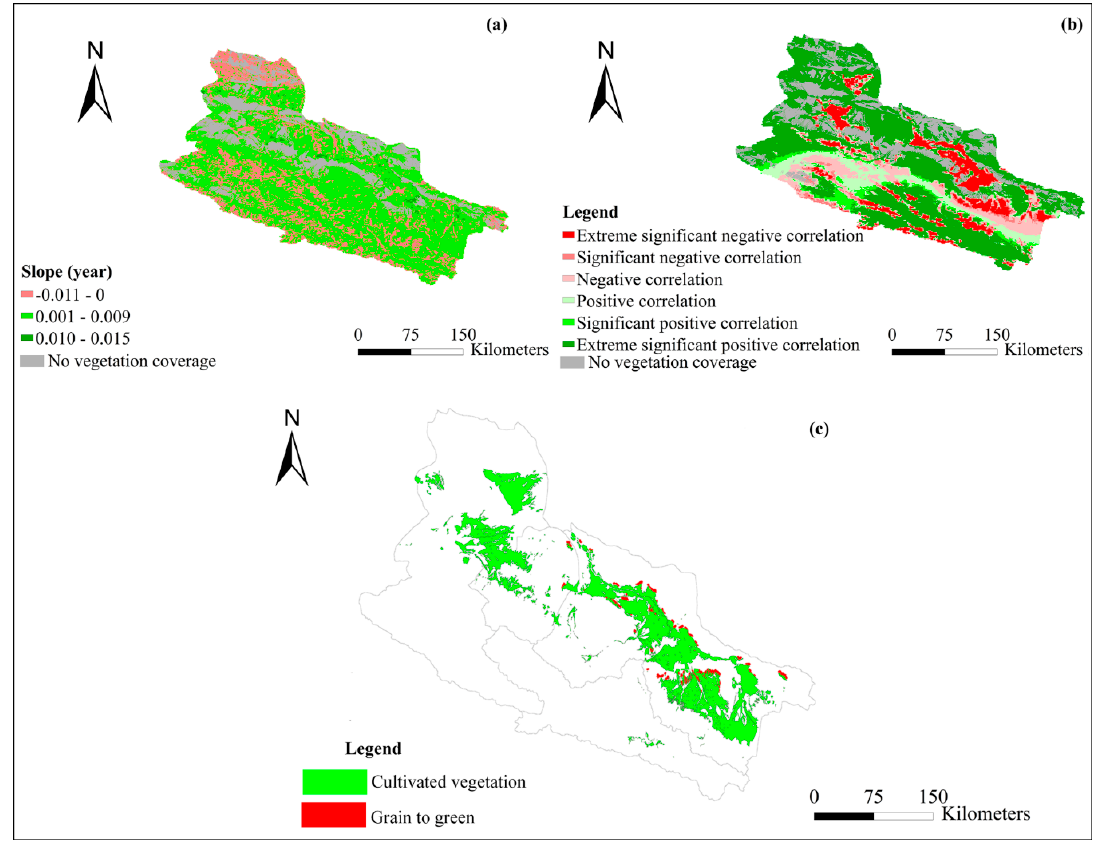
Figure 10. The change trend of the annual and summer (June-July-August) NDVI in the upper (UHRB) and middle (MHRB) reaches of the Heihe River Basin 1998–2015.